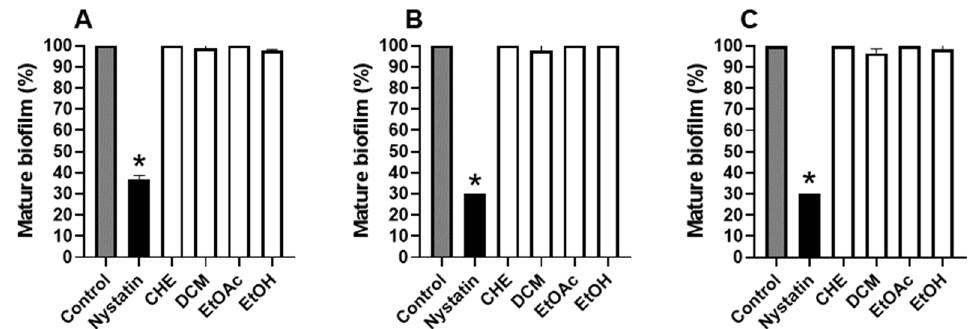
Figure 4. Effects of the Bauhinia holophylla extract and fractions (1250 µg/mL) on mature biofilm of C. albicans . ( A ) C. albicans SC5314; ( B ) C. albicans ATCC 18804; ( C ) C. albicans ATCC 10231. The con-